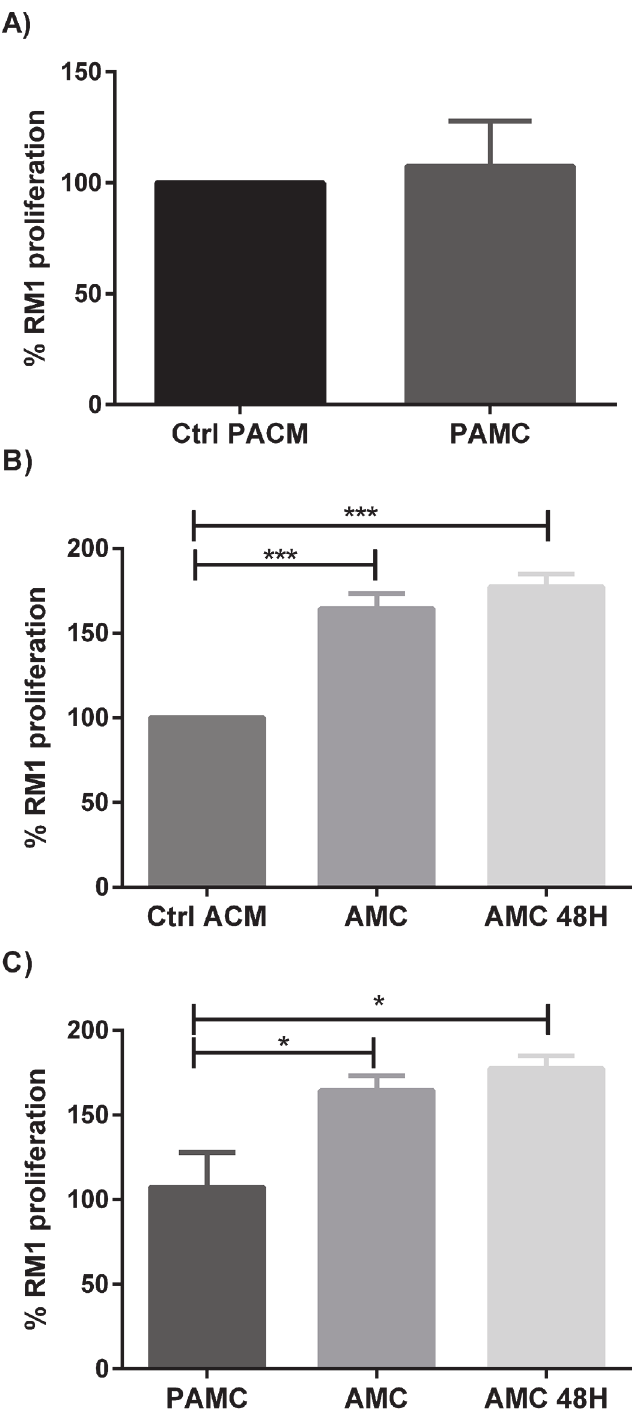
Fig 2. Cell proliferation assay in the presence of conditioned media. RM1 cell proliferation cultured with different conditioned media, assessed by the percentage of tetrazolium salt reduction. RM1 proliferation cultured with preadipocyte conditioned media (PACM) compared with the control (p > 0.05, Mann-whitney U test) (A). RM1 proliferation cultured with 24 and 48h adipocyte conditioned media (ACM) compared with the control ( *** p < 0.001 one-way ANOVA, Newman-Keuls multiple comparison post-hoc test) (B). RM1 Proliferation with three different conditioned media ( * p < 0.05 one-way ANOVA, Newman-Keuls multiple comparison post-hoc test)